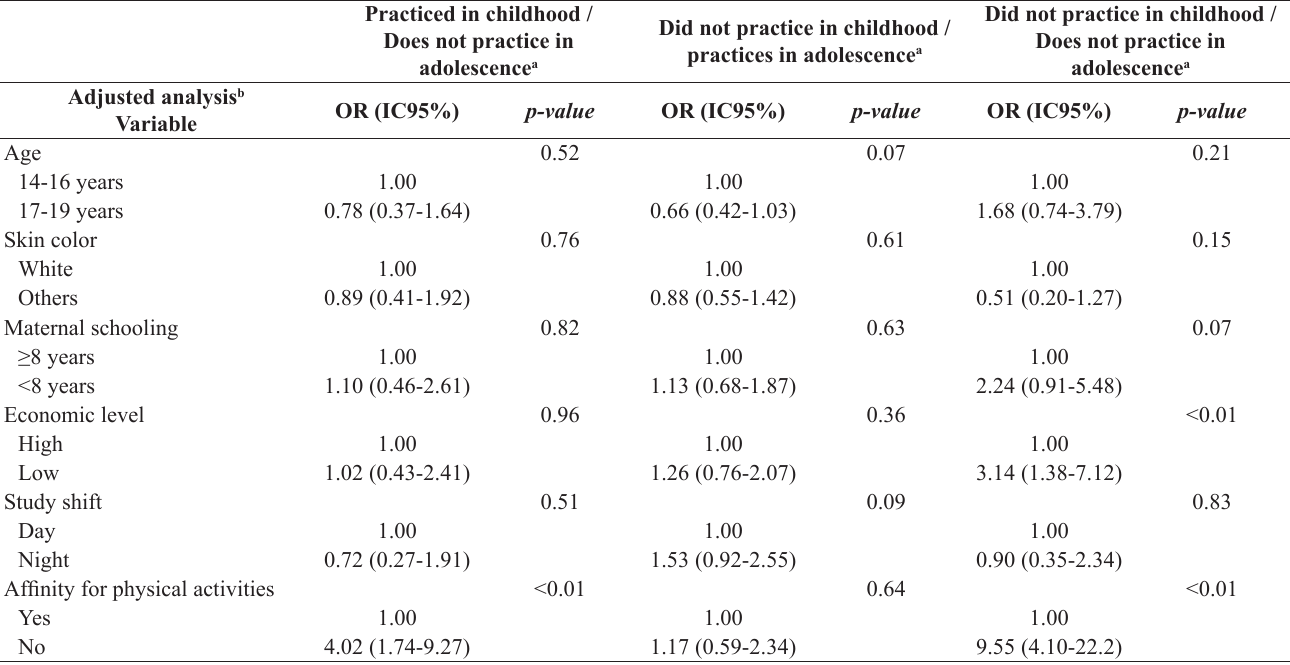
Table 2. Factors associated with sports practice in the period from childhood to adolescence in male students from São José / SC, Brazil